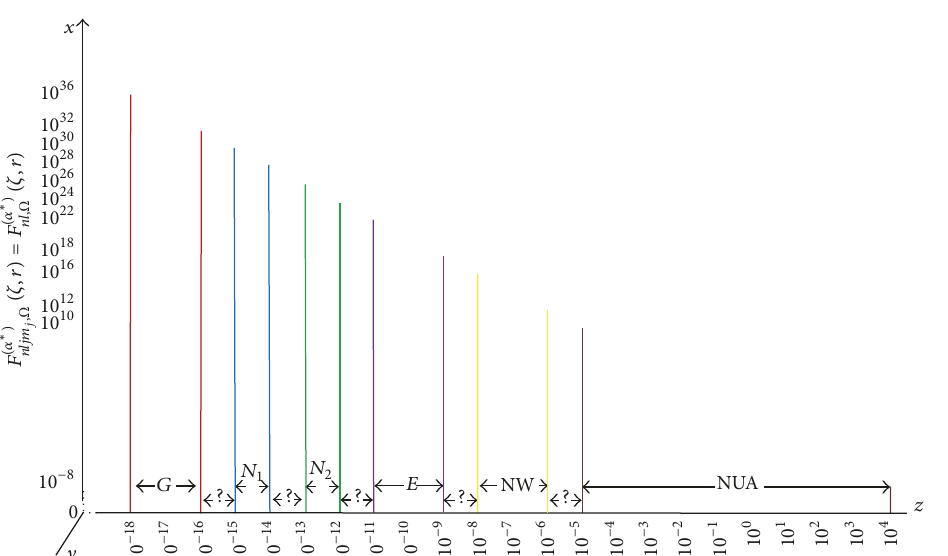
Figure 2: Quantum scalar and SF relativistic NSST attraction forces for 𝜆 = 0 as a function of distance 𝑟 (for 𝑧 = 𝑟 , 𝑛 = 2 , 𝑙 = 1 , 𝑗 = 1/2 , 𝑚 = −1/2 , 𝜁 = 1.5 , 𝛼 ∗ = 0.5 ) for Ω = 𝐺 (10 −18 ≤ 𝑟 ≤ 10 −16 ) , Ω = 𝑁 𝑗 10 −9 ) , Ω = NW (10 −8 ≤ 𝑟 ≤ 10 −6 ) , and Ω = NUA (10 −5 ≤ 𝑟 ≤ 10 4 )